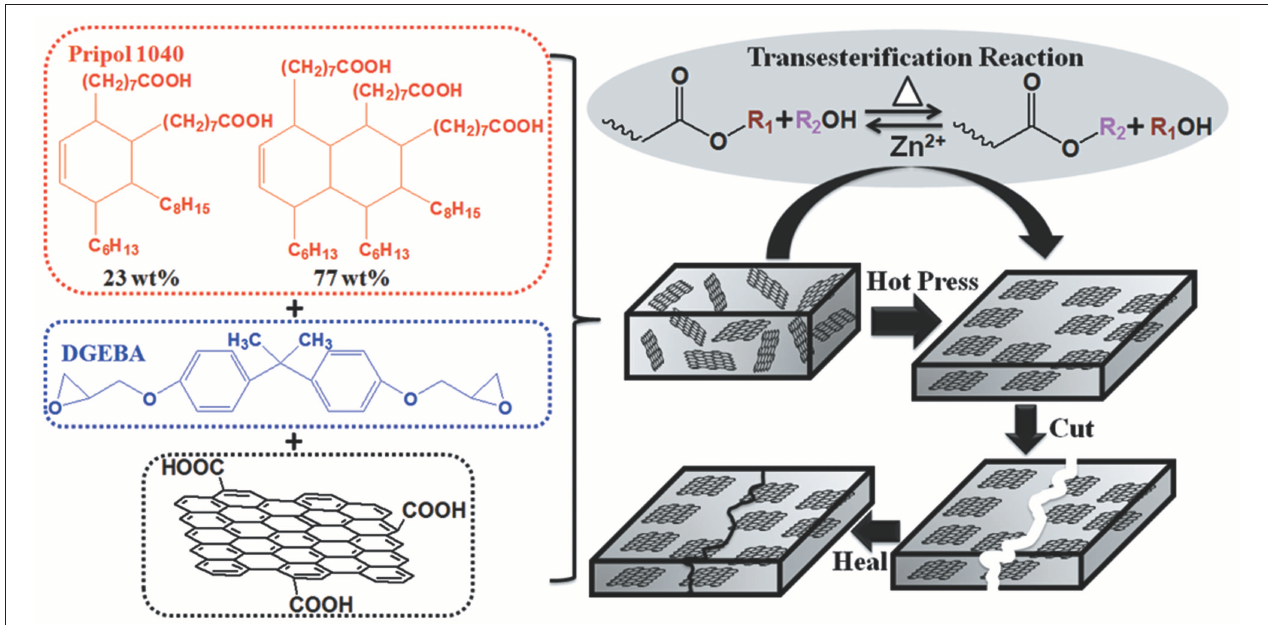
FIGURE 1 | Chemical structure of monomers and the fabrication process of aligned and healable graphene/epoxy